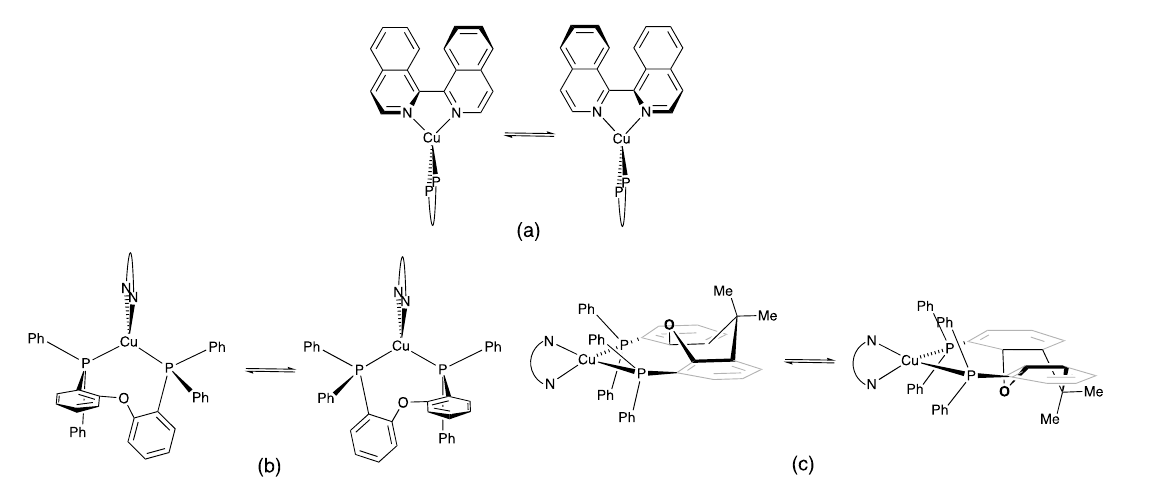
Scheme 4. Dynamic processes in [Cu(POP)(biq)]+ and [Cu(xantphos)(biq)]+: ( a ) atropisomerization of the coordinated biq, Scheme 3. Dynamic processes in [Cu(POP)(biq)] + and [Cu(xantphos)(biq)] + : (a) atropisomerization of the coordinated biq, (b) ( b ) conformational change of the POP backbone, and ( c ) conformational change of the xanthene unit in conformational change of the POP backbone, and (c) conformational change of the xanthene unit in xantphos.